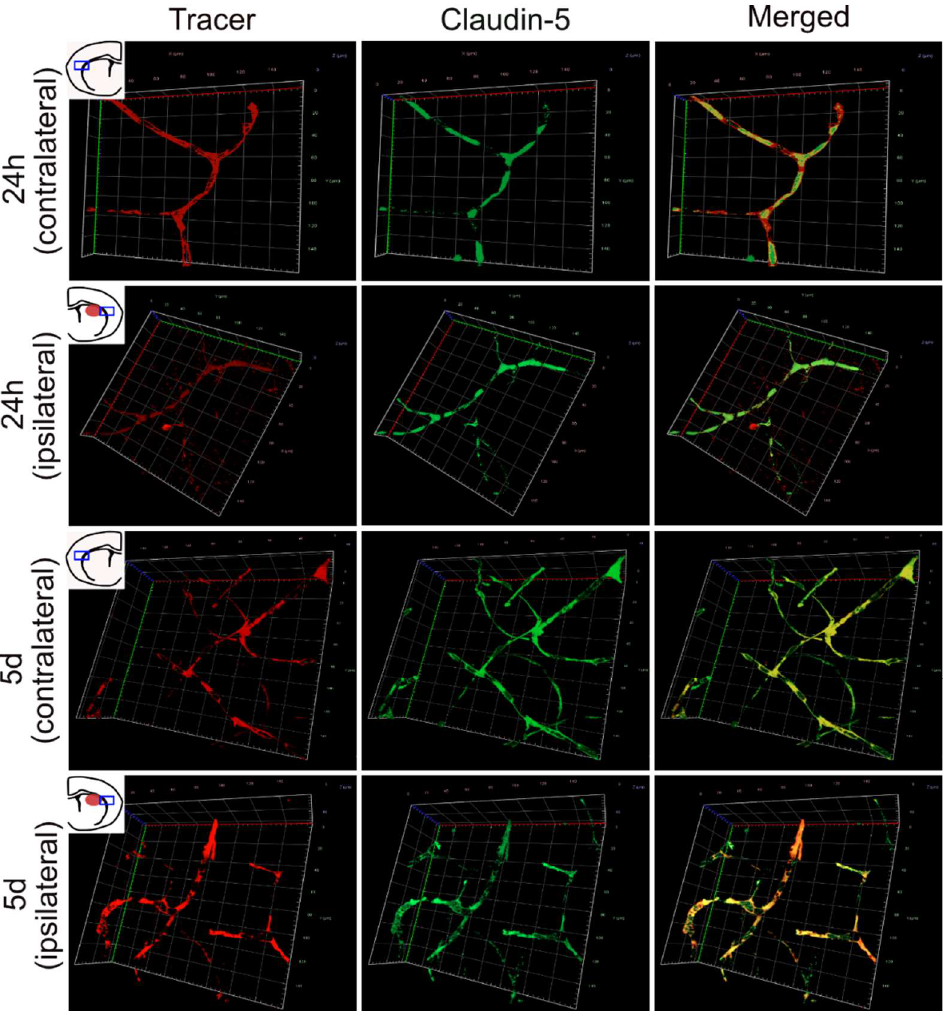
Figure 3. Three-dimensional imaging of tracer and CLDN5 in brains following GMH. Representative images of 3D-imaged z-stacks of vessels immunolabelled for claudin-5 (CLDN5) and tracer molecule taken in the peri-hematoma region of the ipsilateral hemisphere or the corresponding area in the contralateral hemisphere. At 24 h the CLDN5 labelling was discontinuous in vessels that also showed lost barrier integrity (tracer not contained within the vessel) in the ipsilateral hemisphere, while at five days, barrier integrity was re-established in blood vessels with continuous CLDN5 labelling and tracer contained within vessels. In the contralateral side of the brain, CLDN5 immunolabelling always remained continuous, and tracer remained within blood vessels. The x- and y-axes are 140 µm.